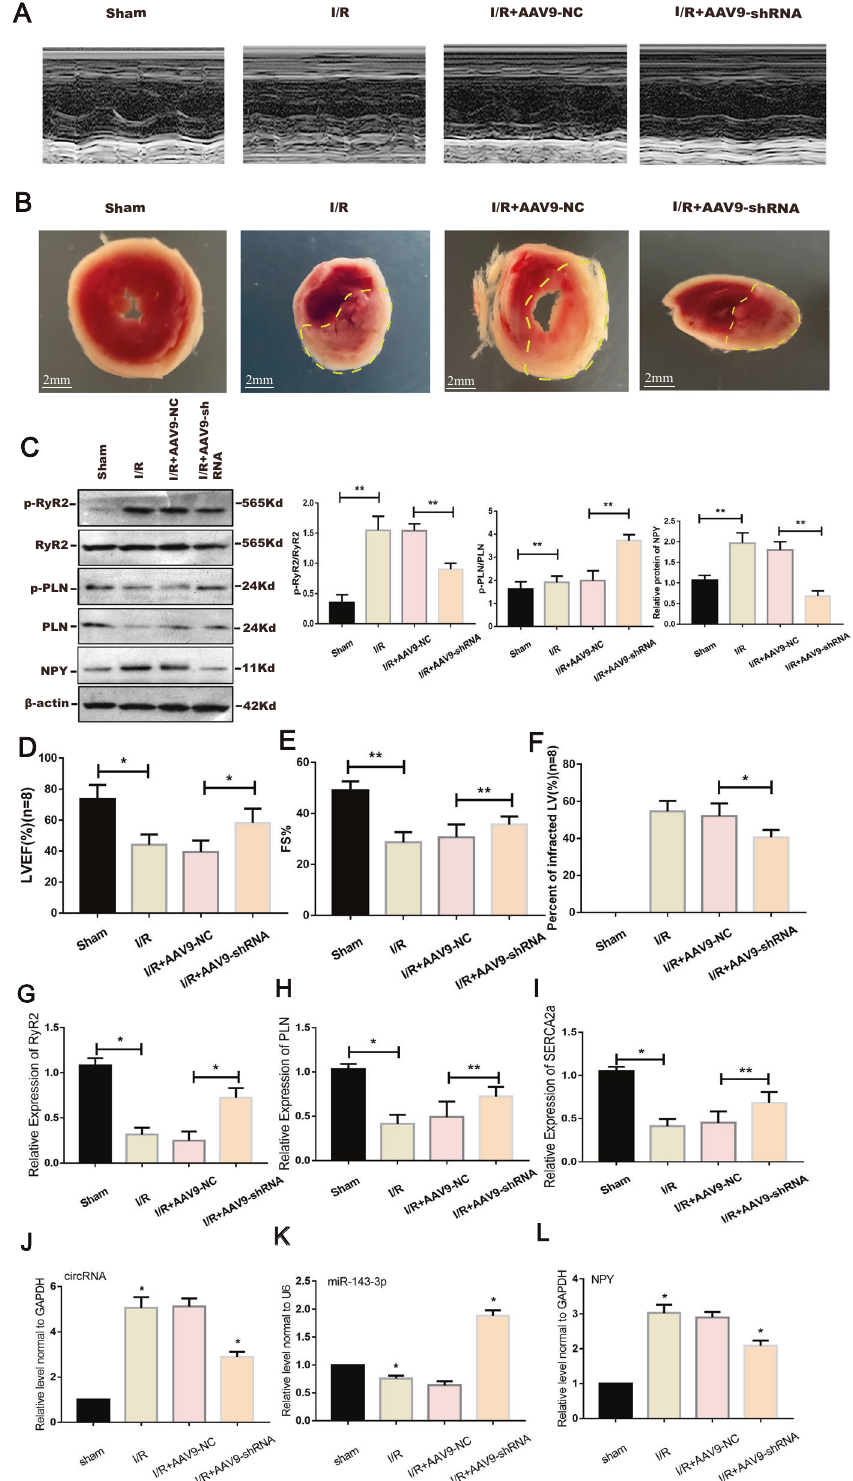
Fig. 8 Inhibiting mmu_circ_0000021 expression reduced the infarct size and improved cardiac function following I/R. A , D , E LV function was determined by echocardiograms ( A ) including EF ( D ) and FS ( E ). B , F The size of the infarct and the region of the myocardial infarction were determined using TTC. C In the sham group, the amount of RyR2, PLN, and their phosphorylated forms were reduced. G – L qRT-PCR showed changes in PLN, RyR2, SERCA2a and the changes of miR-143-3p/NPY axis after the inhibition of mmu_circ_0000021 expression. * P < 0.05, ** P < 0.01, vs. indicated group; n =